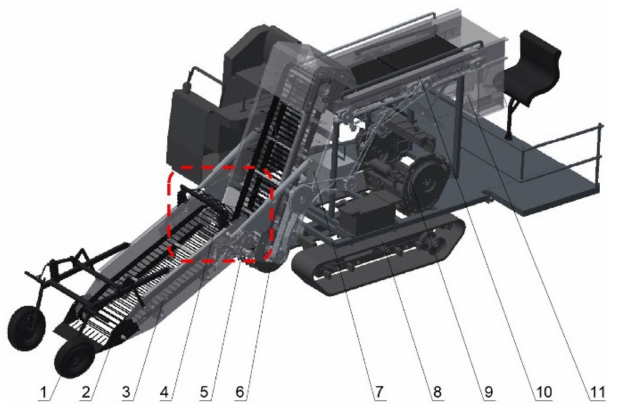
Figure 1. Structure diagram of the small self-propelled potato combine harvester. 1. Depth limiting device; 2. Excavation shovel; 3. Separating rod sieve; 4. Stem guide bar; 5. Grooved stem picking roller; 6. Curved handing part; 7. Lifting and conveying mechanism; 8. Tracked chassis; 9. Engine; 10. Selecting table; 11. Potato collection